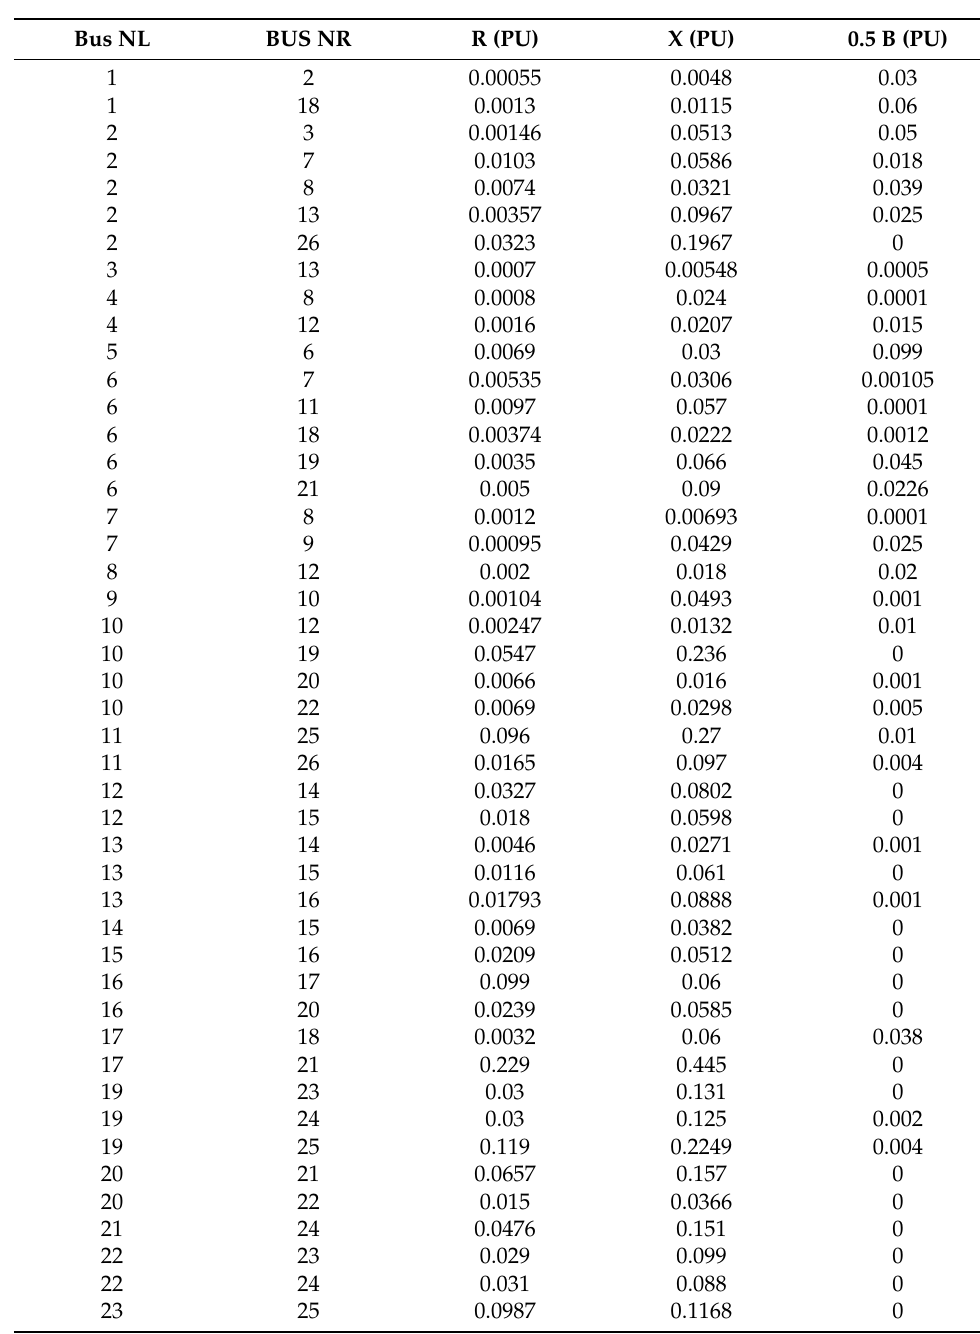
Table A1. Line data for IEEE 26